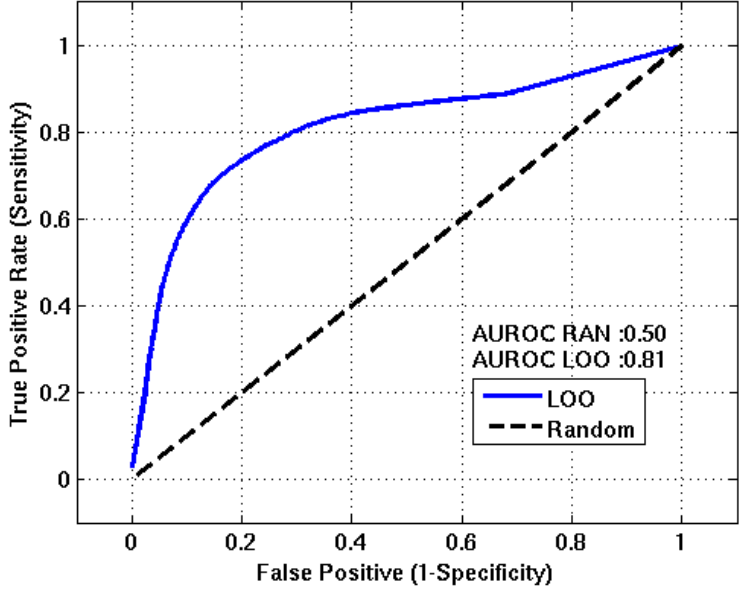
Figure 7. Receiver Operating Characteristics for the intensity event tree node. The AUROC value of approximately 0.80 suggests this node will have fair to good predictive capabilities. TPR, FPR, accuracy, and precision estimates of 73%, 19%, 78%, and 70% are obtained at the optimum detection threshold,